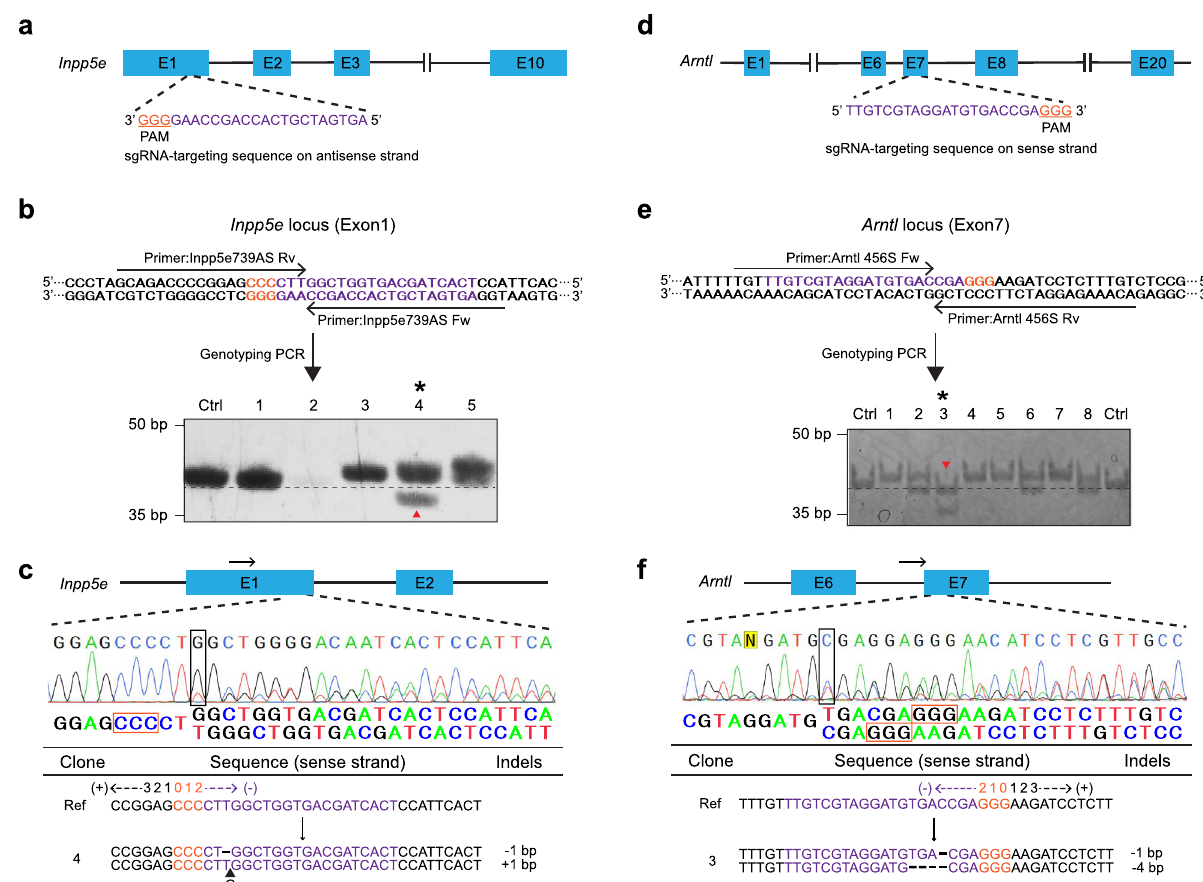
Figure 3. Detection of deletion mutations via DST-PCR ( a ) Scheme of the Inpp5e guide RNA targeting exon 1 in the murine Inpp5e gene. ( b ) DST-PCR for screening mutations. Upper panel: The arrows indicate the locations of the DST-PCR primers (see Table 1). Bottom panel: TBE-high-resolution-PAGE of DST-PCR products. Lane Ctrl: PCR product (39-bp) amplified from the genomic DNA of wild-type unedited cells. Clone #4 (*) exhibited a lower shifted band (red arrowhead) ( c ) Sanger sequencing of the PCR products of clone #4 (* in panel b) around the PAM sequence (orange rectangle). Split sequences were shown under the spectrum. Start of split sequences are highlighted as black rectangle. The arrows indicate the locations of the sequencing primers (see Table 1). ( d ) Scheme of the Arnt1 guide RNA targeting exon 7 in the murine Arnt1 gene. ( e ) DST-PCR for screening mutations. Upper panel: The arrows indicate the locations of the DST-PCR primers (see Table 1). Bottom panel: TBE-high-resolution-PAGE of DST-PCR products. Lane Ctrl: PCR product (40-bp) amplified from the genomic DNA of wild-type unedited cells. Clone #2 (*) exhibited two lower shifted bands (red arrow head). ( f ) Sanger sequencing of the PCR products of clone #2 (* in panel e) around the PAM sequence (orange rectangle). Split sequences were shown under the spectrum. Start of split sequences are highlighted as black rectangle. The arrows indicate the locations of the sequencing primers (see Table 1). The 20-bp sgRNA and 3-bp PAM sequences are highlighted in magenta and orange respectively. Wild-type sequence (Ref), base deletion (−), base insertion ( ▲ ). Original gels are presented in Supplementary Raw Data. Created in Adobe Illustrator CC V26.2.1 (https:// adobe. com/ produ cts/ illus